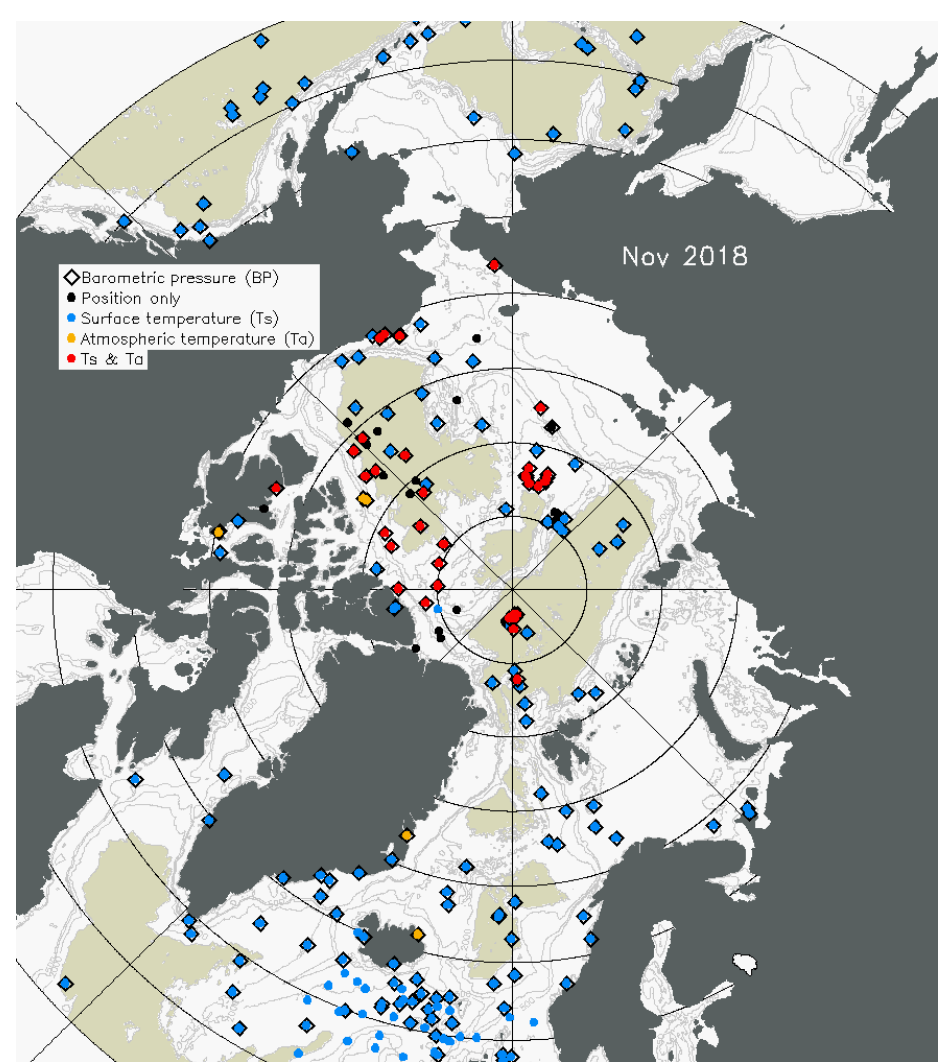
Figure 4. Distribution of sea ice and ocean buoys in November 2018. Reproduced from http://iabp.apl.washington.edu/monthly_maps.html (last access: 4 February 2019) with